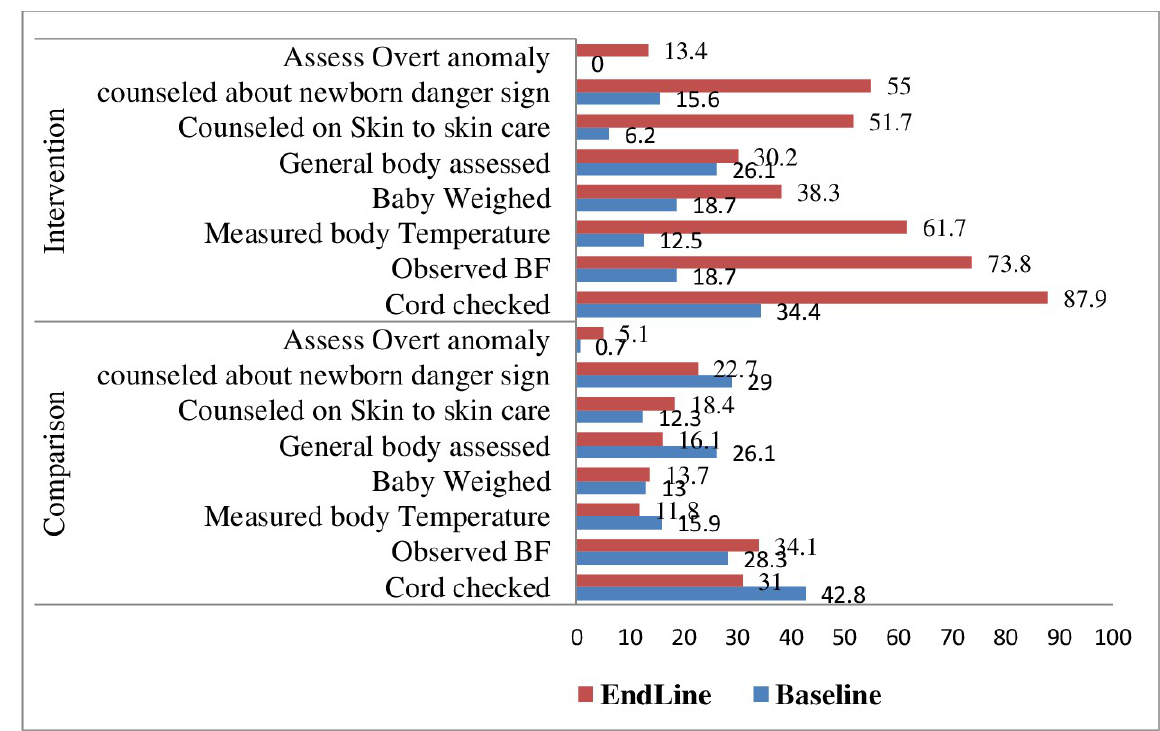
Fig 1. Proportion of newborn postnatal contents provided by HEWs during